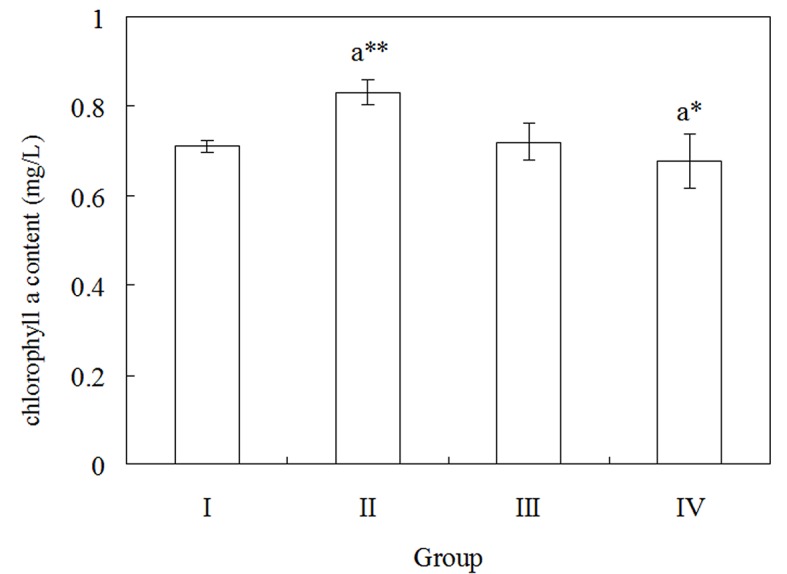
The changes of chlorophyll a in cells of cyanobacterium Anabaena PD-1 exposed to different concentrations of Aroclor 1254.The result was presented as the mean values of quadruplicate experiments (**P<0.01, *P<0.05; ‘a’ indicates group II, III, IV vs. the control group I).